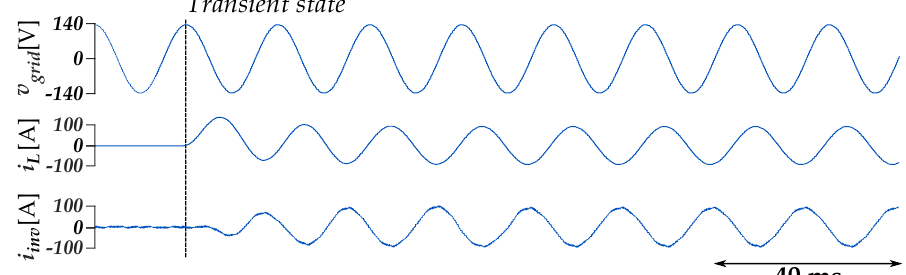
Figure 17. Simulated waveforms confirming the compensation effectiveness of load voltage control.